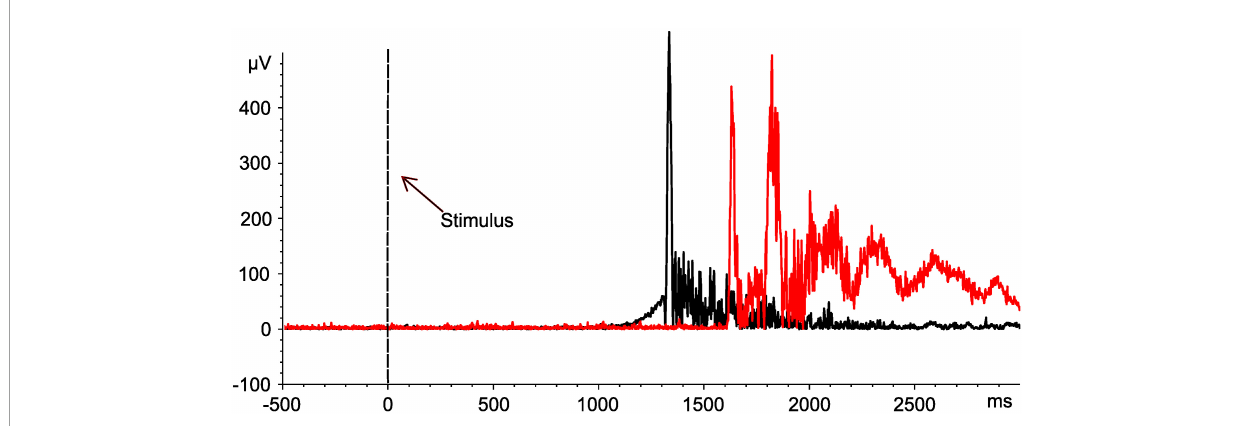
FIGURE4 Assessment of nerve conduction velocities for determination of nerve fiber types. Motor responses of an individual with spinal cord injury (No. 10). EMG signals of the tibialis anterior muscle after stimulation at both the head of the fibula (black curve) and the sole of the foot (red curve). Based on the distance between the two stimulation sites (42 cm), the determined shift in latency (561 ms) is compatible with the conduction velocity of the C-fibers (0.75 m/sec). The black dashed line indicates the onset of the stimulus.